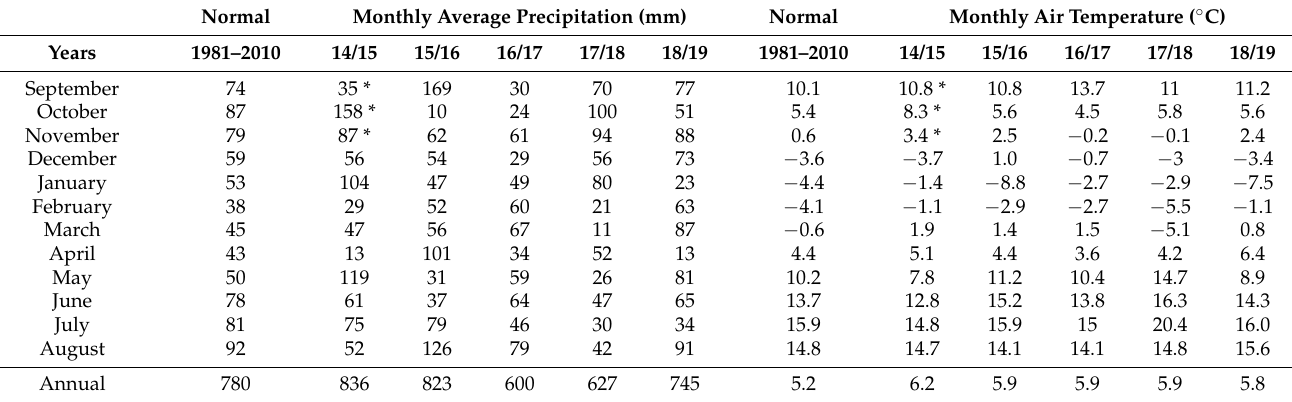
Table 4. Measured monthly precipitation (mm) and average monthly air temperatures ( ◦ C) during the five years at Kjelle meteorological station